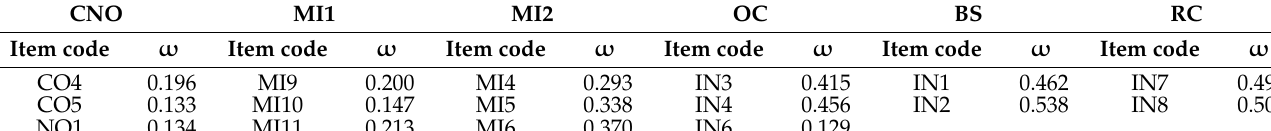
Table 1. Weights ( ω ) for individual measurement items of respective